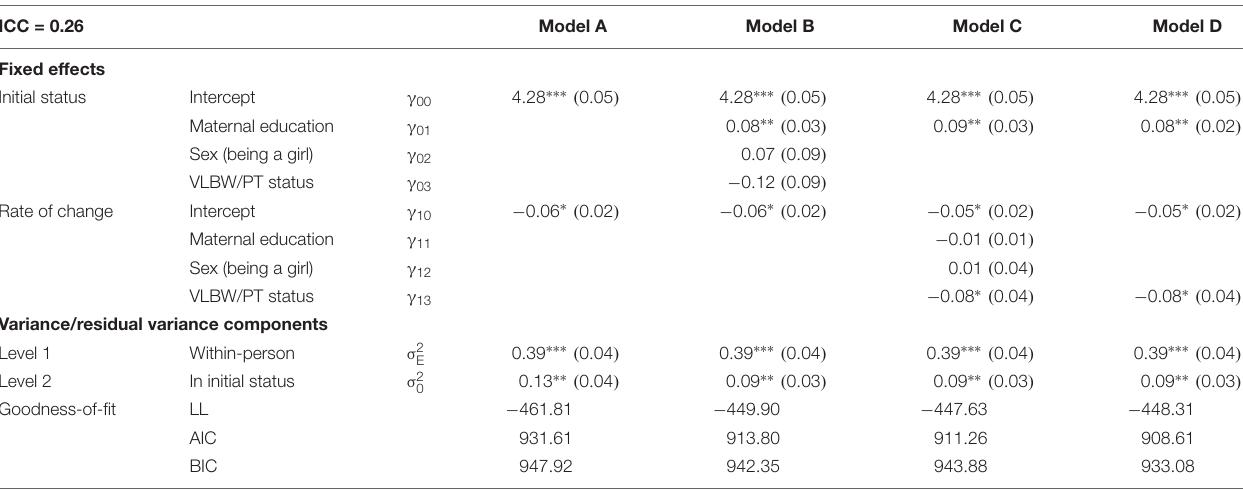
TABLE 4 | The growth models of maternal structuring between 6 and 57 months. ICC =